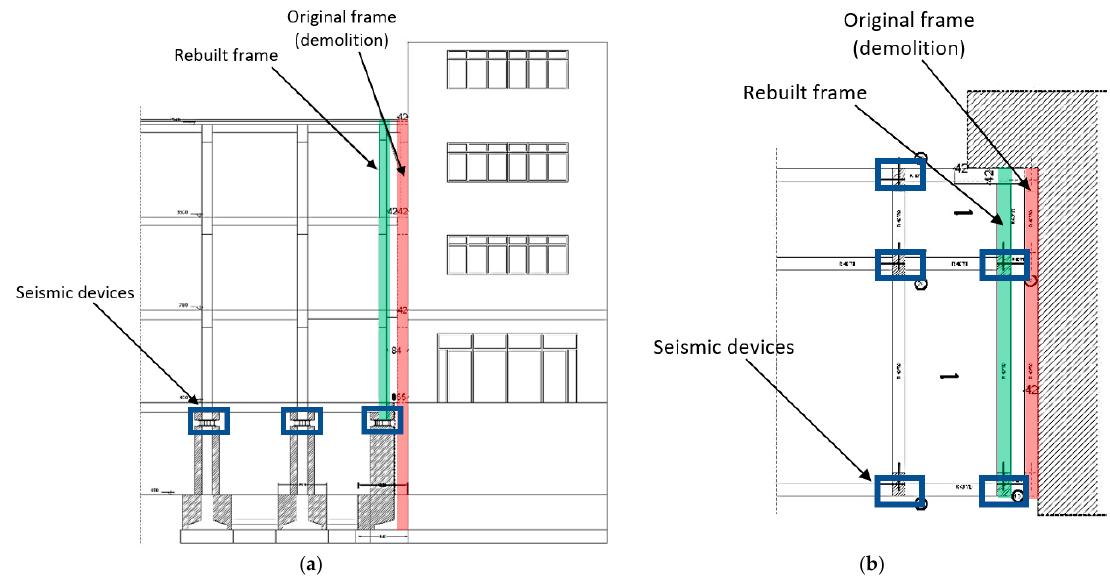
Figure 13. Detail of seismic joint: ( a ) vertical cross-section and ( b ) plan view.